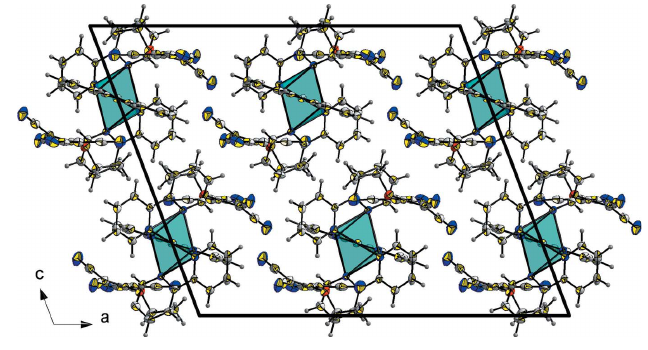
]. Displacement 2 Figure 2 A view along the b axis of the crystal packing of compound (I).